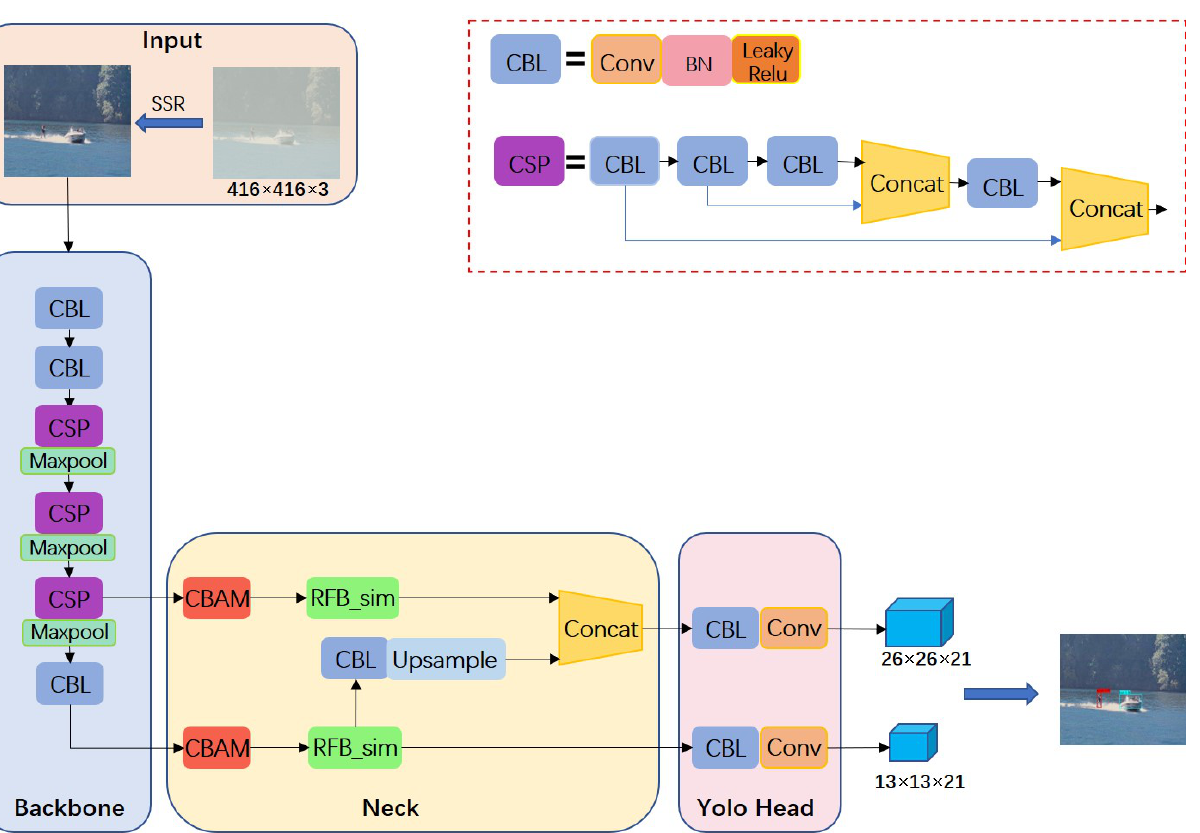
Figure 1. The network structure